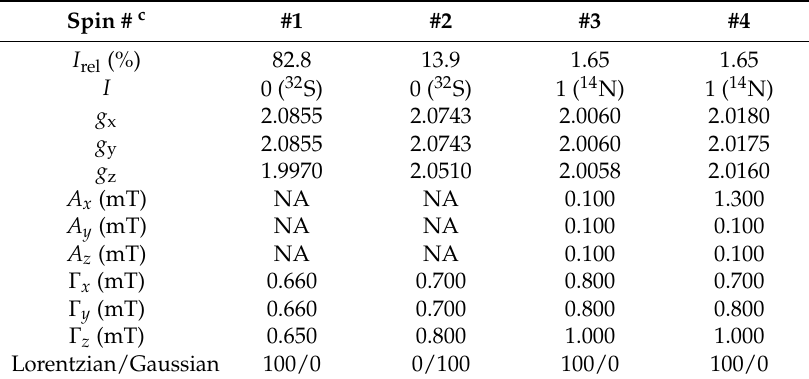
Table A1. Parameters for simulated spectrum of γ‐ salt a,b .